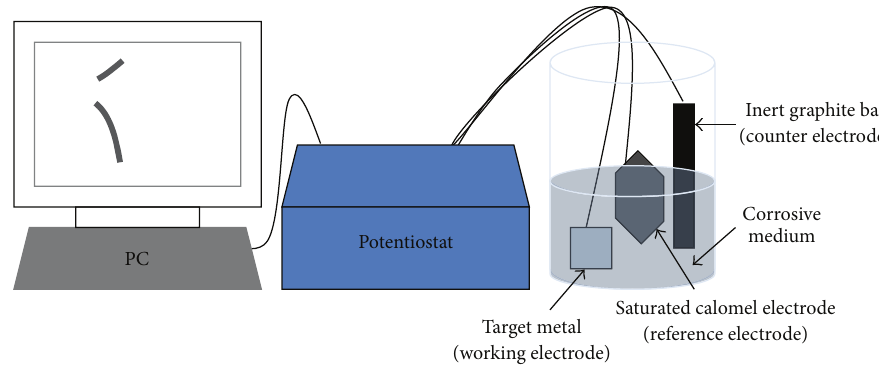
Figure 4: The experimental set-up to test the electrochemical